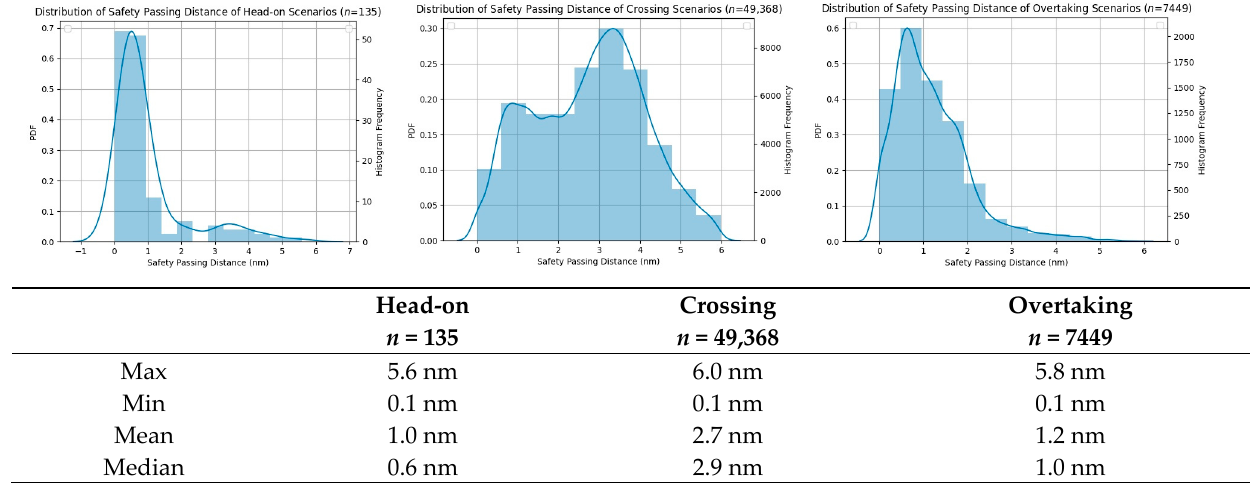
Figure 8. Distribution of duration time for different encounter scenarios.